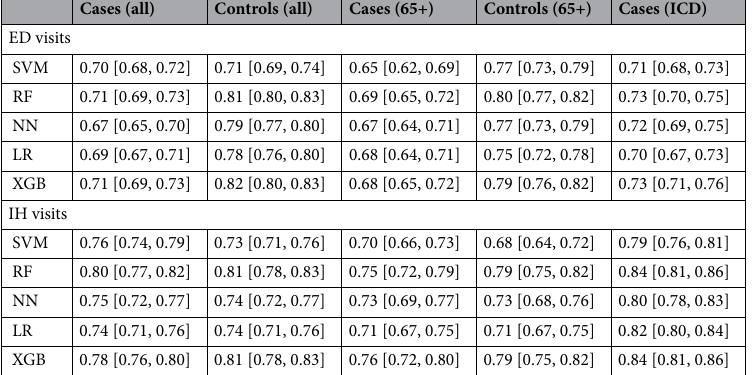
Table 6. Intra-cohort evaluation: AUC and 95% confidence interval of test samples for models trained on sociodemographic variables (So) and ATC medication groups (Rx).